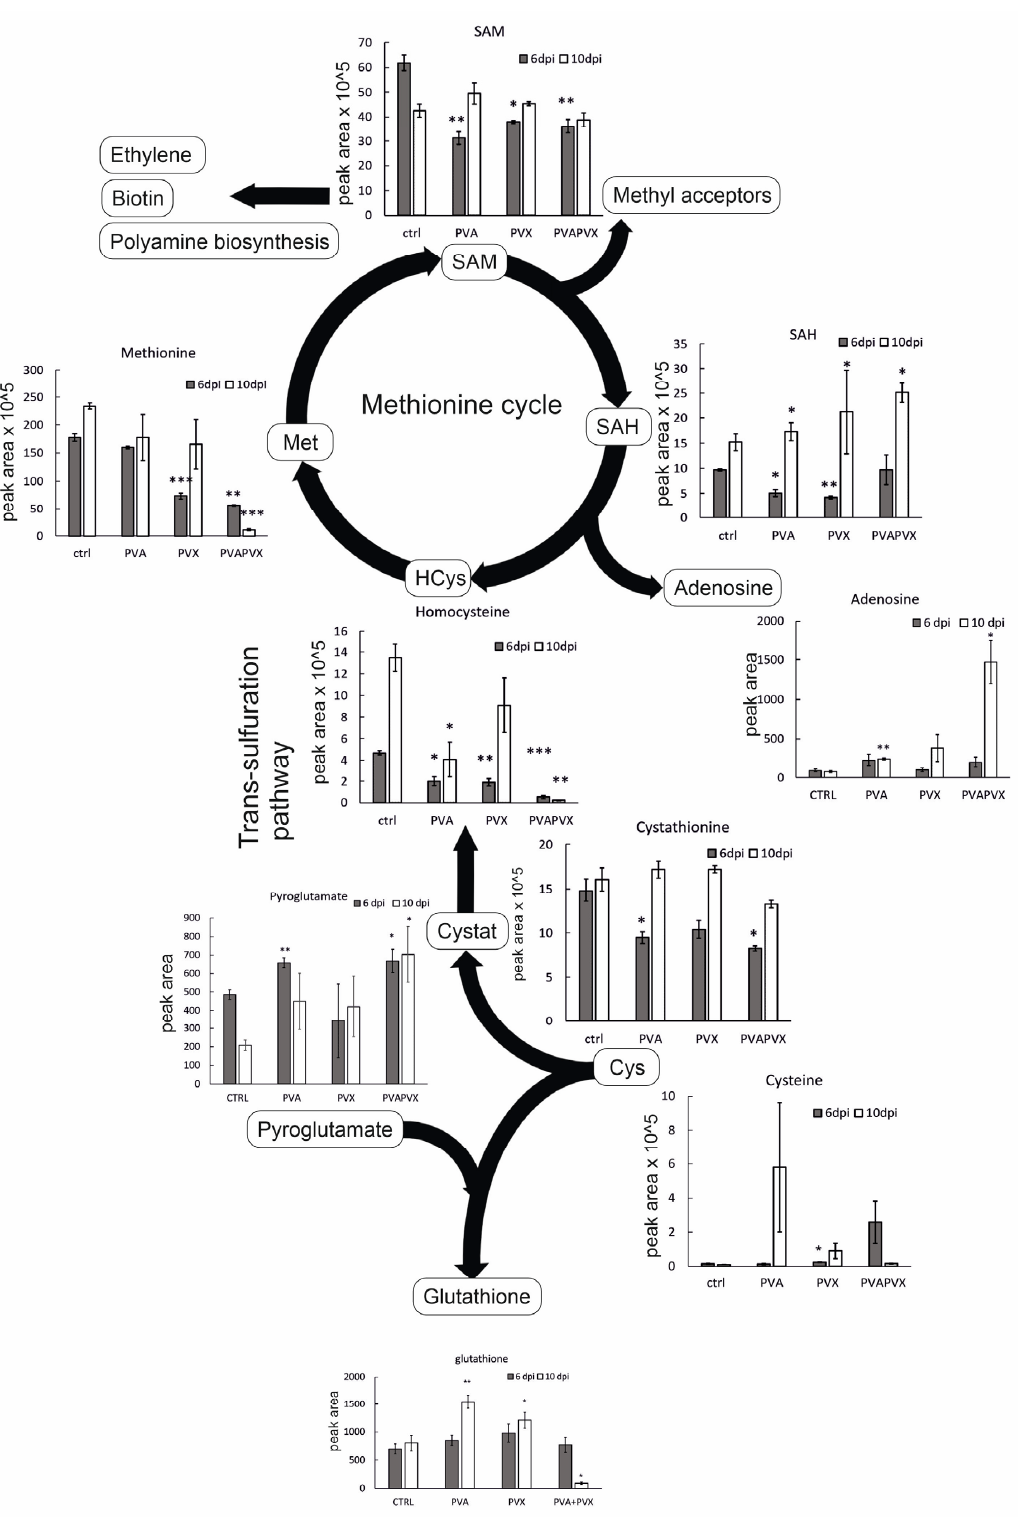
Figure 5. Levels of methionine cycle intermediates and selected metabolites in single and mixed infections. Data represents averages of one experiment, statistical significance compared to the healthy controls of the same day was calculated with Student’s t -test (* p < 0.5, ** p < 0.01, *** p < 0.001). The following abbreviations are used: cysteine (Cys), cystathionine (Cystat), homocysteine (HCys), methionine (Met), S-adenosylmethionine (SAM), S-adenosylhomocysteine (SAH). The diagram was created with